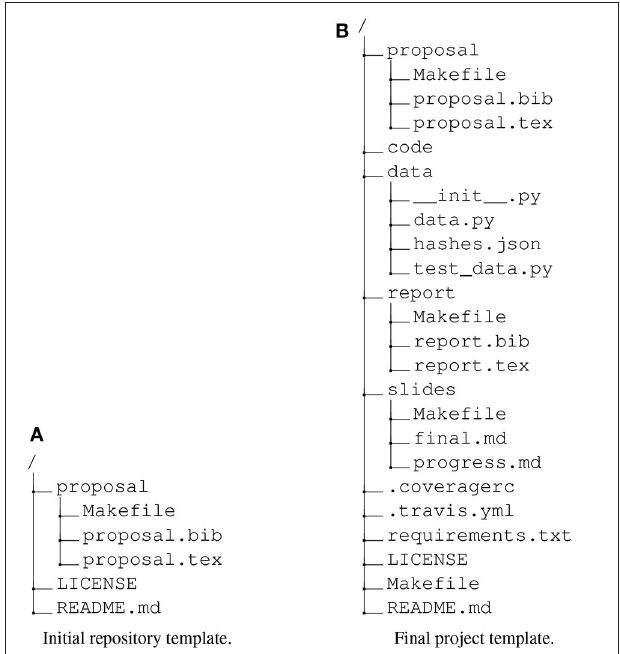
FIGURE 1 | The initial and final repository directory template for student projects. We gave the students a project copied from the initial template in week 5, from which they would write and build and their initial proposal. As the course progressed, we pushed two updates to their repository. The first gave them a template for building their final report, their top-level README.md file and file specifying an open license for their work. The second gave them: an initial set of functions we had shown them in class with associated tests (in the code directory, not shown); machinery to trigger automatic execution of tests on Travis-CI servers; automated code coverage reporting; and a template for writing slides for their first progress report. (A) Initial repository template. (B) Final project